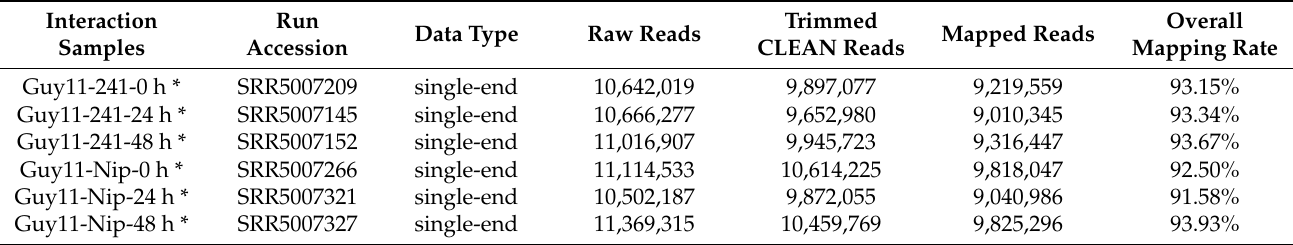
Figure 1. Identification and distribution of alternatively spliced genes (ASGs) in rice. ( a ) Compu- tational pipeline for genome-wide detection of alternative splicing (AS) events and differentially alternatively spliced genes (DASGs). ( b ) Venn diagram of comparison of StringTie-produced tran- scripts and annotated transcripts by gffcompare Kit. ( c ) Distribution of differentially expressed genes (DEGs) across all samples. ( d ) The numbers of all seven types of alternative splicing events across all samples. A3: Alternative 3 ’ splice-site; RI: Retained intron; A5: Alternative 5 ’ splice-site; SE: Skipped exon; AF: Alternative first exon; AL: Alternative last exon; MX: Mutually exclusive ex- ons. Table 1. Data accession and mapping rate of data used in this